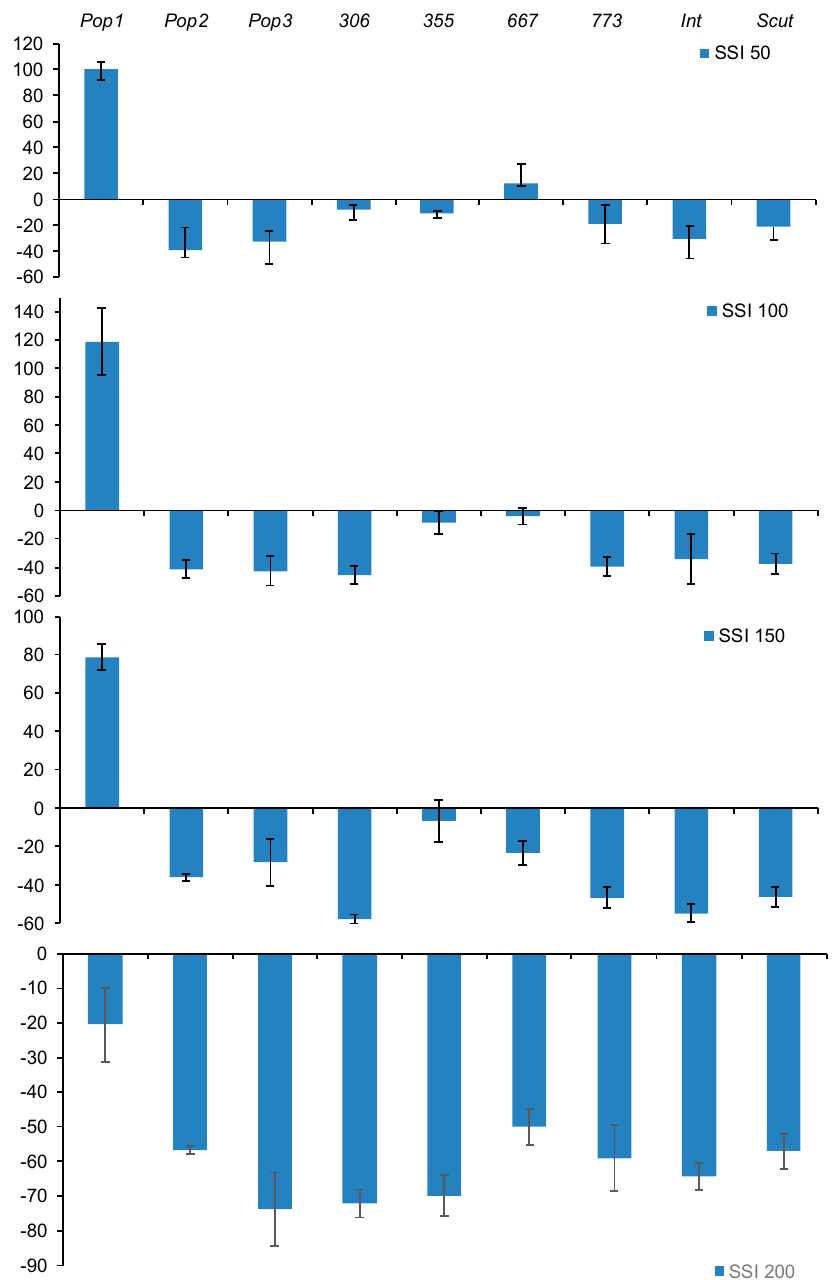
Figure 5. Effect of salt stress (0, 50, 100, 150, 200 mM NaCl) on sensitivity index SI ( SI ( DW ) ) for growth of seven populations of M. ciliaris ( Pop1, Pop2, Pop3, 306, 355, 667, 773 ), compared to one population of M. intertexta ( M. int ), and one population of M. scutellata ( M. Scut ). The means are averages of 25 plants (5 plants / n=5 repetitions for each salt treatment). The error bars show standard deviation; p < 0.05.